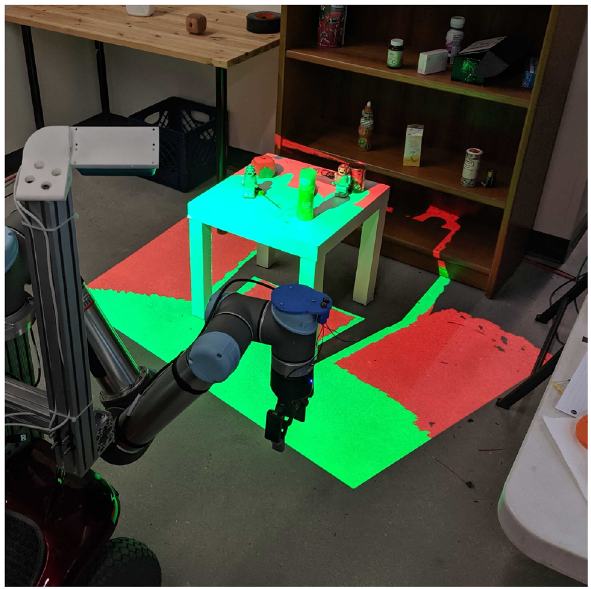
Figure 11: Projection mapping showing grasp radius. Objects that can be grasped are highlighted in green, and objects that are out of reach of the arm are highlighted in red.